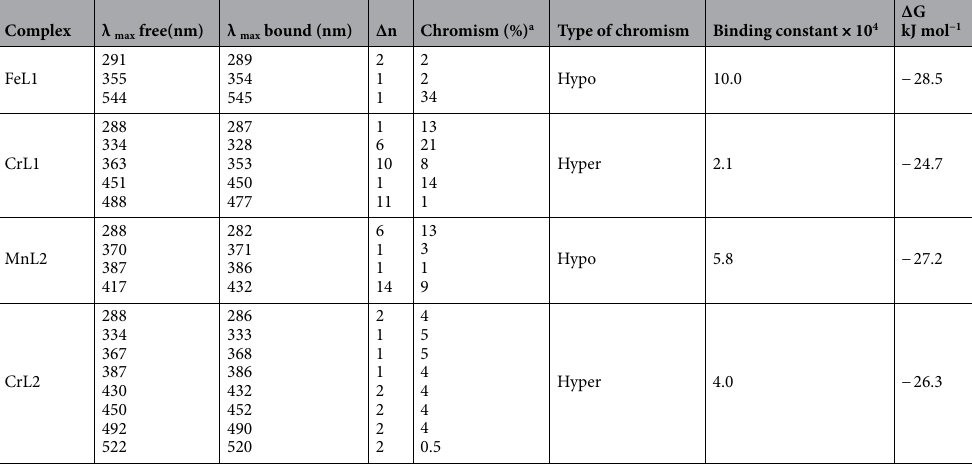
Table 10. Values for the spectral parameters that govern how FeL1, CrL1, MnL2, and CrL2 complexes interact with CT-DNA.